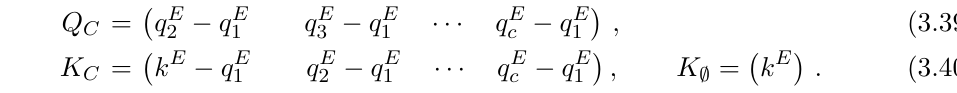
Figure 1 . The simplex the loop